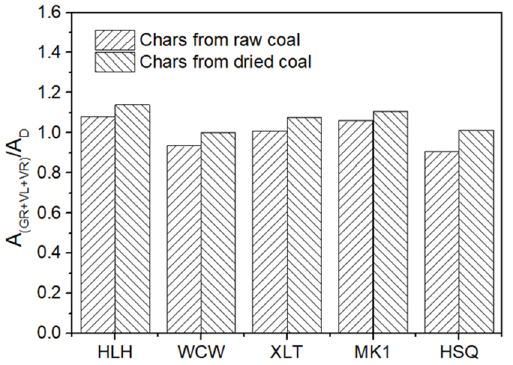
Figure 5. A comparison of A (GR+VL+VR) /A D of pyrolytic char from raw coal and dried coal.